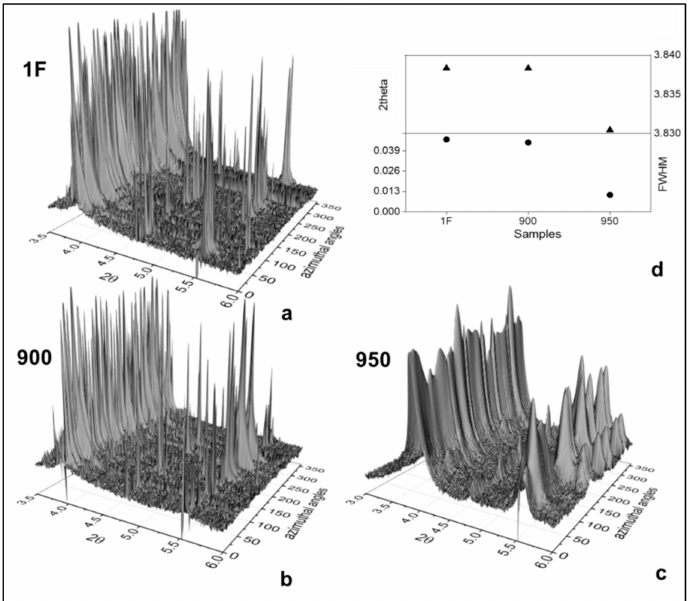
Figure 5. 3D plots transform of Debye–Scherrer diffraction rings (azimuthal angles) vs. 2 θ for ( a ) as-forged (1F), ( b ) 900, and ( c ) 950 samples and ( d ) 2 θ and FWHM